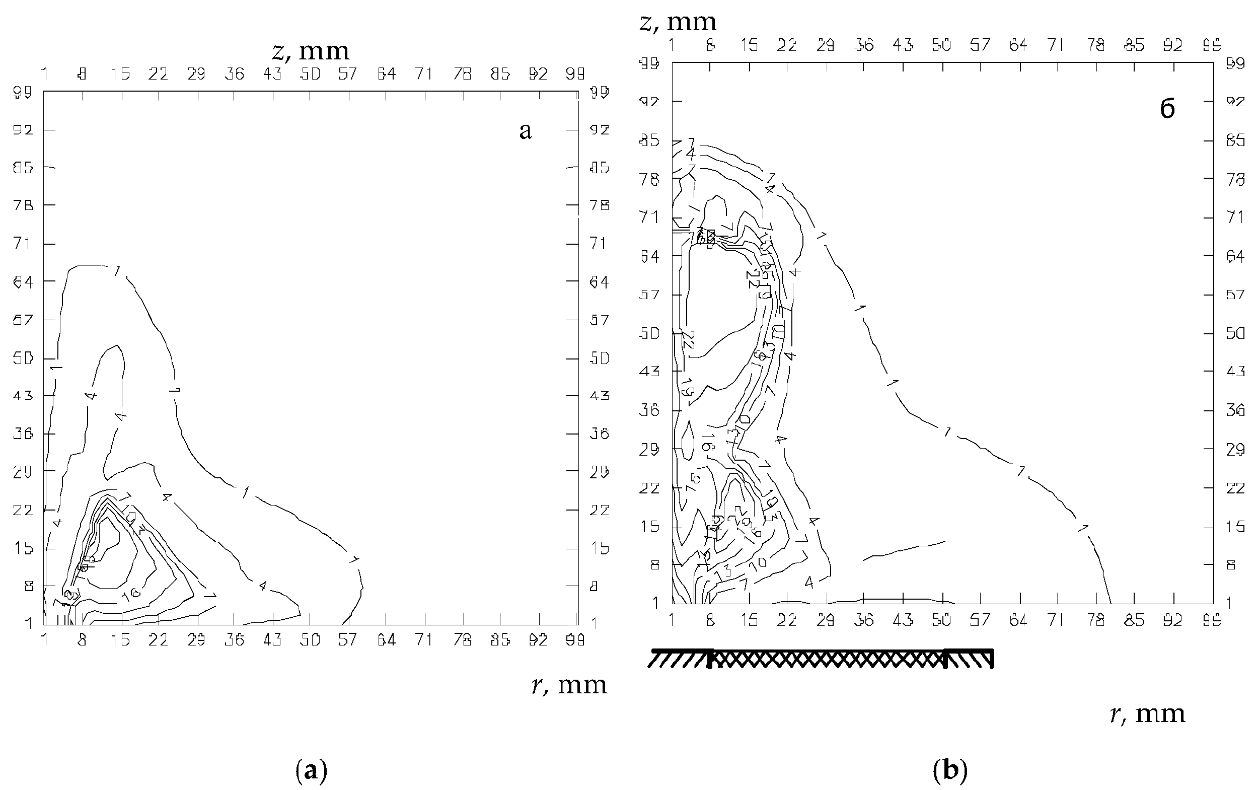
Figure 3. Lines of the Alfven velocity V A (km/s) ( a ) and the velocity modulus V (km/s) ( b ) at the time instant t = 15.3 μs at the discharge current J = 281 kA for the MPC with parameters C = 750 μF, U 0 = 5 kV in argon with pressure. p = 10 − 2 MPa ( A m = 0.6 )